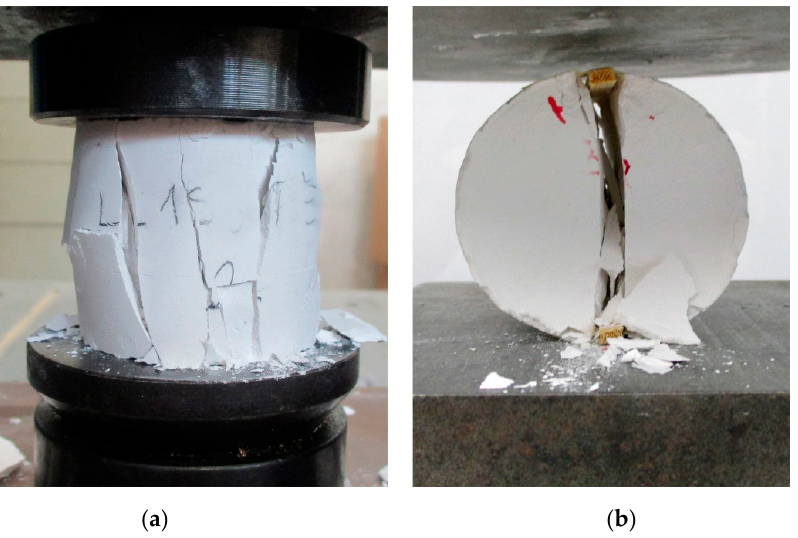
Figure 4. ( a ) Compressive and ( b ) splitting tensile strength for SI and CH mixtures. Figure 5. Examples of failure modes: ( a ) Compressive strength and ( b ) splitting tensile strength for SI and CH mixtures.